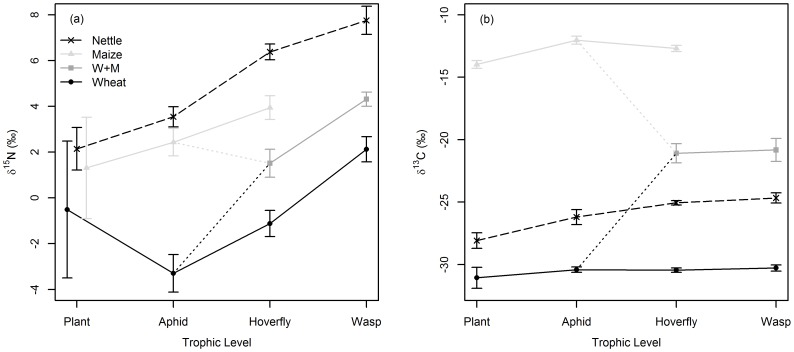
δ15N (a) and δ13C (b) across four trophic levels of four replicate terrestrial food chains.Mean ± SD (‰) are shown. n = 6 to 15. For plant δ15N, mean ± SD are offset on x-axis for clarity. Dotted lines are trophic links between two aphid prey sources and their hoverfly predator.